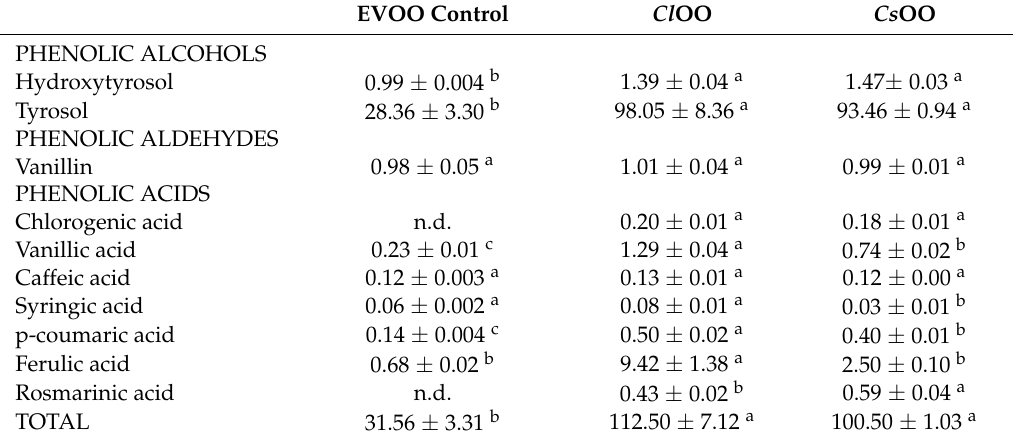
Table 7. Changes in the composition of phenolic alcohols, aldehyde and acids ( µ g/mg phenols) in lemon olive oil ( Citrus limon olive oil Cl OO), orange olive oil ( Citrus sinensis olive oil Cs OO), control extra-virgin olive oil (Control EVOO). Each value represents mean ± standard deviation ( n =